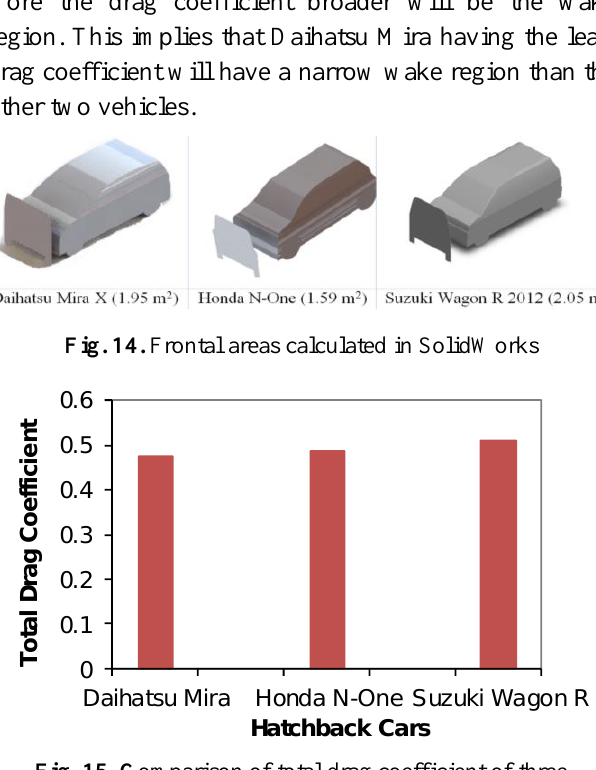
Fig. 15. C omparison of total drag coefficient of three hatchback